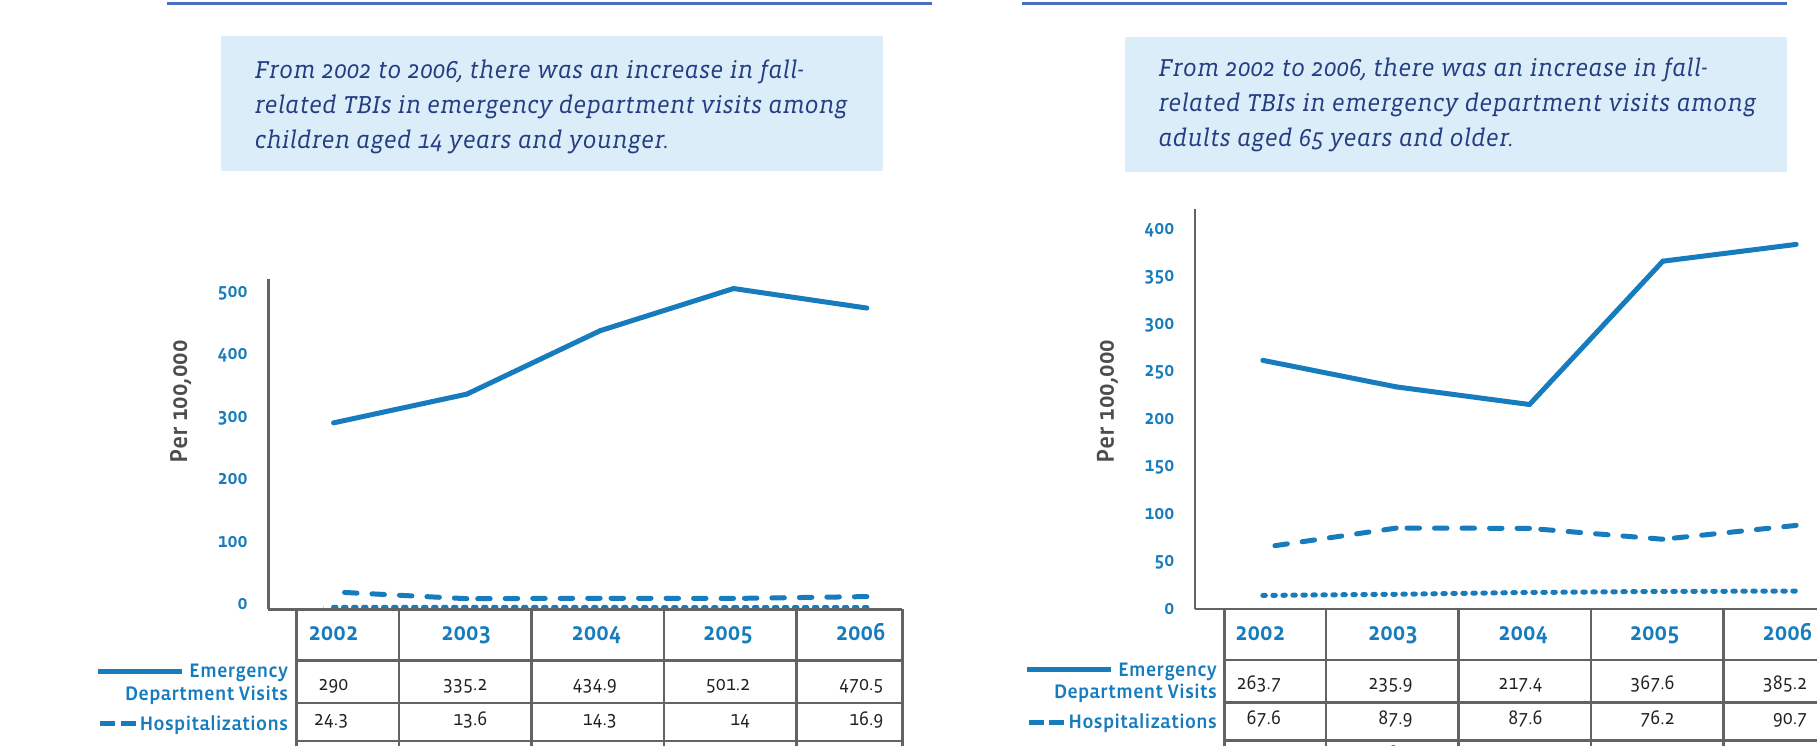
FIGURE 9: Annual Rate Estimates of Fall–Related Traumatic Brain Injury-Related Emergency Department Visits, Hospitalizations, and Deaths Among Children Aged 0–14, United States, 2002–2006